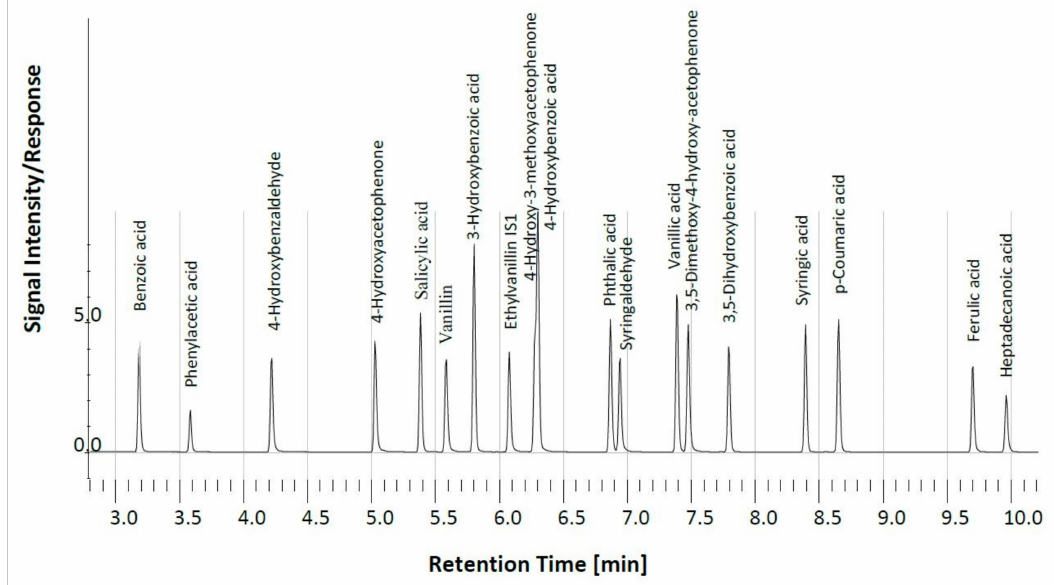
Figure 1. Typical gas chromatogram of phenolic compounds released after alkaline CuO oxidation of Lobelia rhynchopetalum